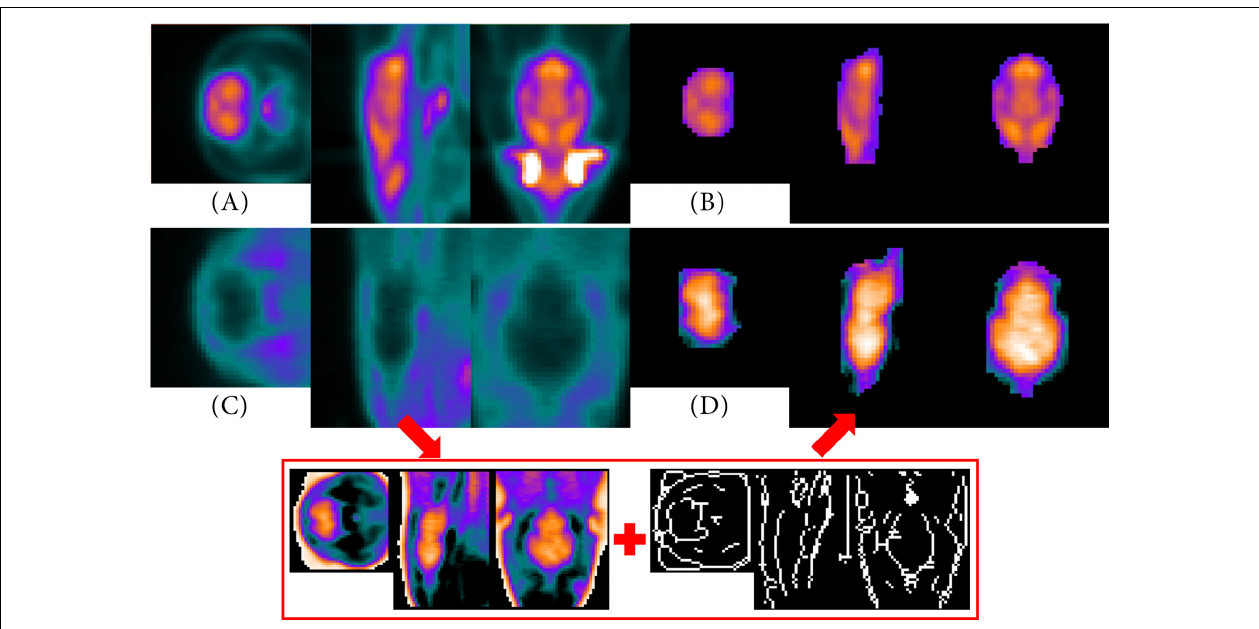
FIGURE 5 | PET templates and segmented VOI. Images (A,B) are based on (i) seven sham-operated Sprague Dawley rats including [ 18 F]FDG as applied radiotracer. (C) Represents a PET template averaged over (iii) 14 Wistar rats with a stroke lesion (applied radiotracer: [ 68 Ga]Ga-Fucoidan). Using intensity inversion and the skeletonized gradient image (red box), the VOI can be segmented (D) . Since [ 68 Ga]Ga-Fucoidan is a target-specific accumulating radiotracer, there is only low uptake in other regions of the VOI than the target itself, e.g., in the “healthy tissue” of the brain. However, due to the intensity adjustments and inversion, it appears that the larger “healthy tissue” of the brain shows a high radiotracer uptake, while the smaller region, which was targeted by the radiotracer, presents almost no accumulation.